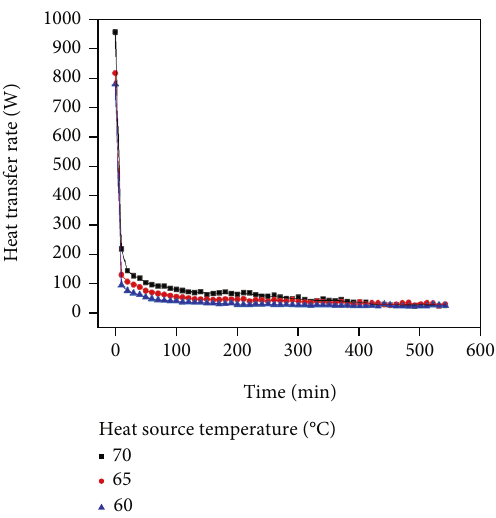
14: Heat transfer rate of heat storage device with a di ff erent heat source temperature.